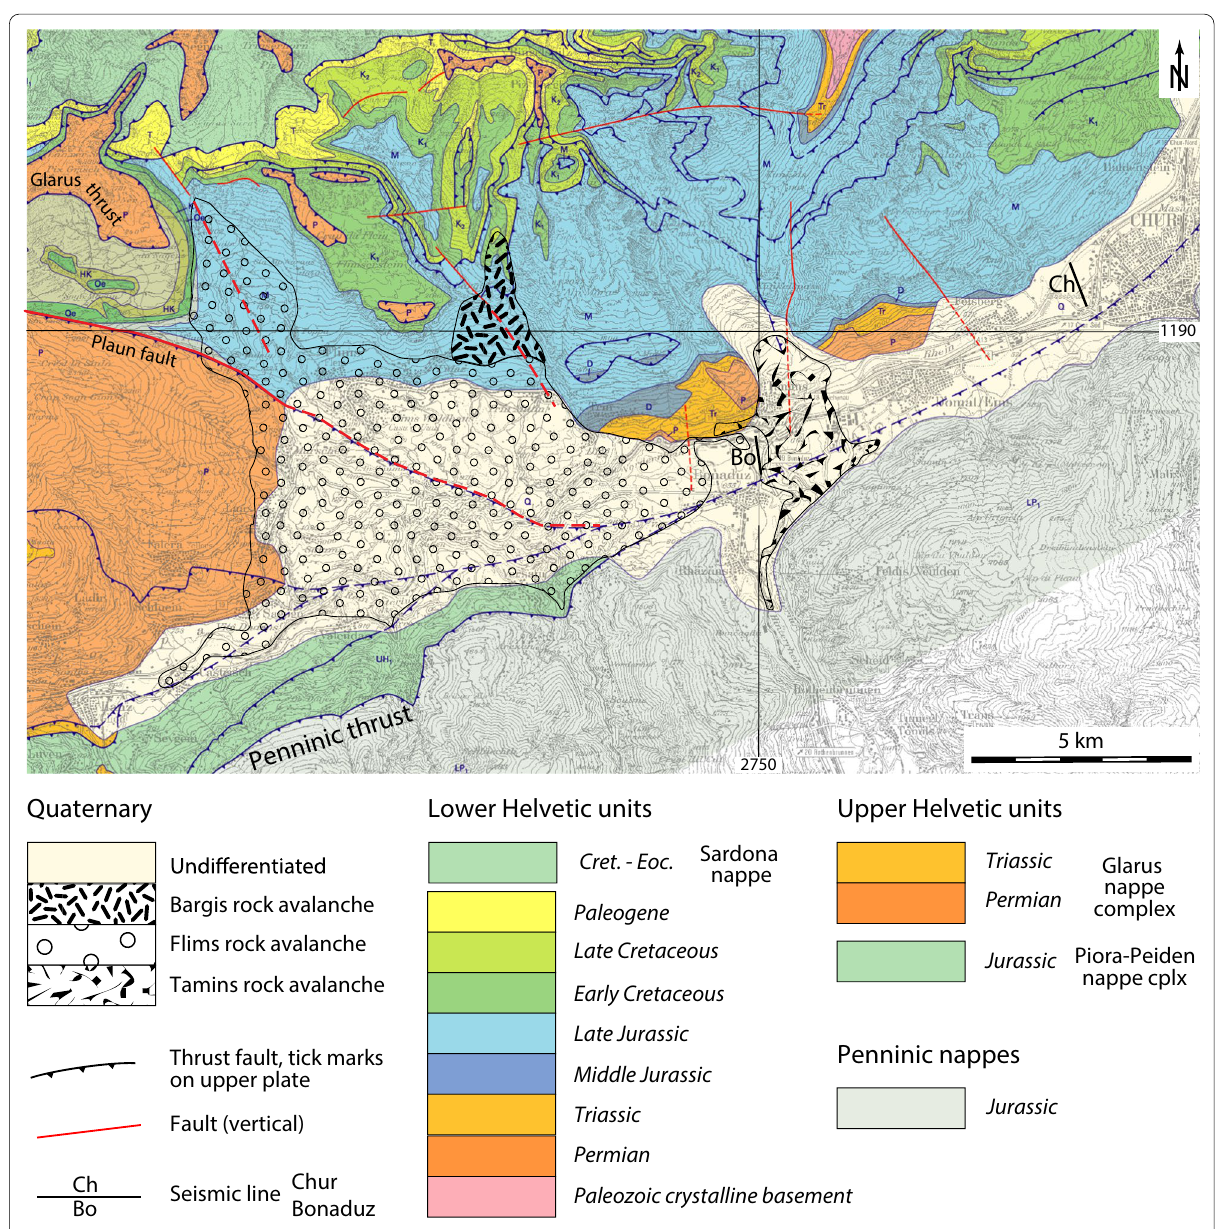
Fig. 2 Simplified geologic map of the study area (modified from Pfiffner et al.